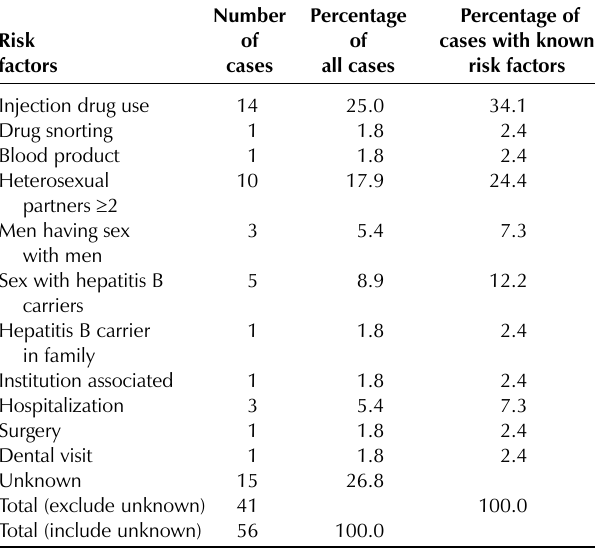
Distribution of mutually exclusive risk factors for acute and likely acute hepatitis B in four health regions, 1998 to 1999, among those who were interviewed (56 of 79,